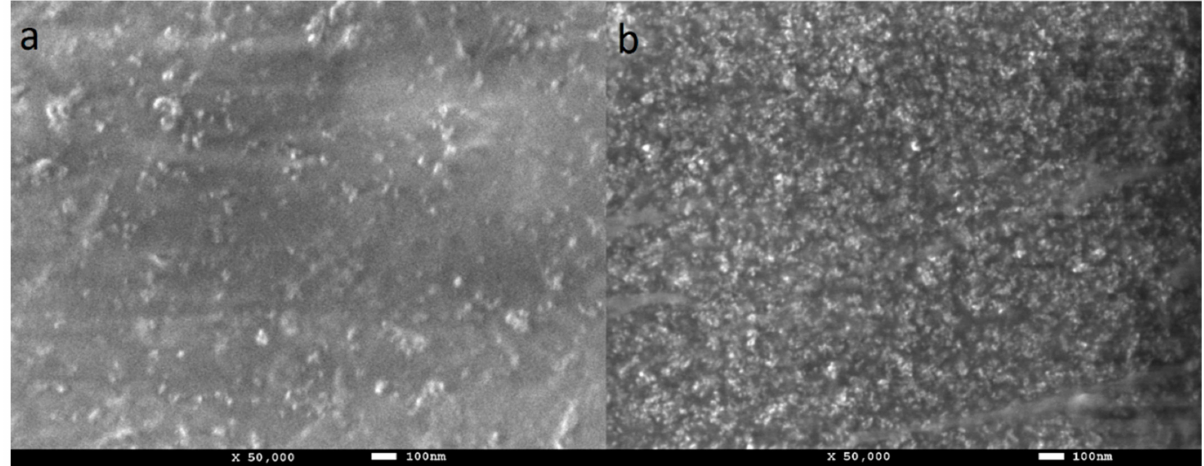
Figure 6. SEM photographs of the cast film surfaces of ( a ) PVA-ND/1 and ( b ) PVA-ND/3